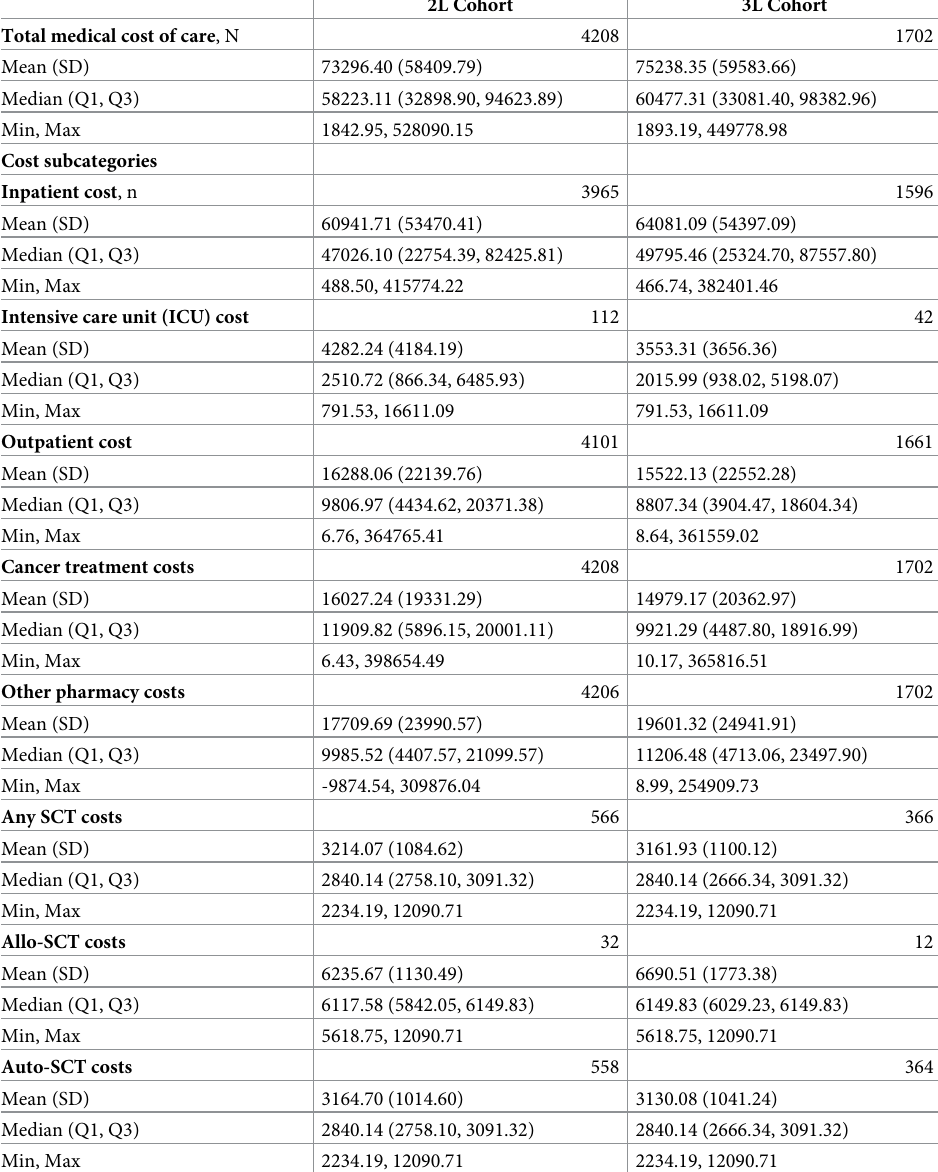
Table 3. Healthcare costs (USD) during